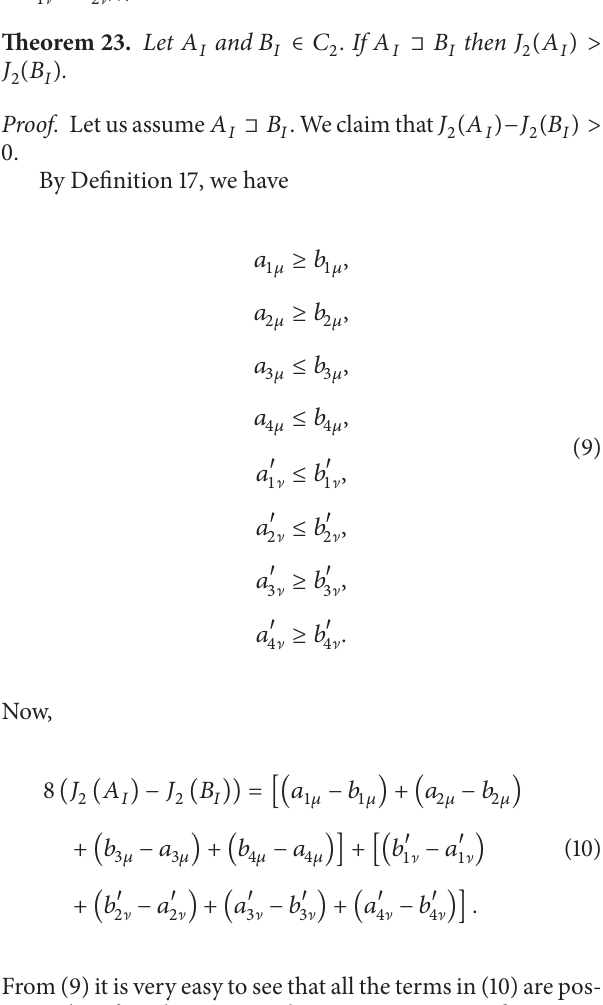
Figure 3: Pictorial representation of Example 16.